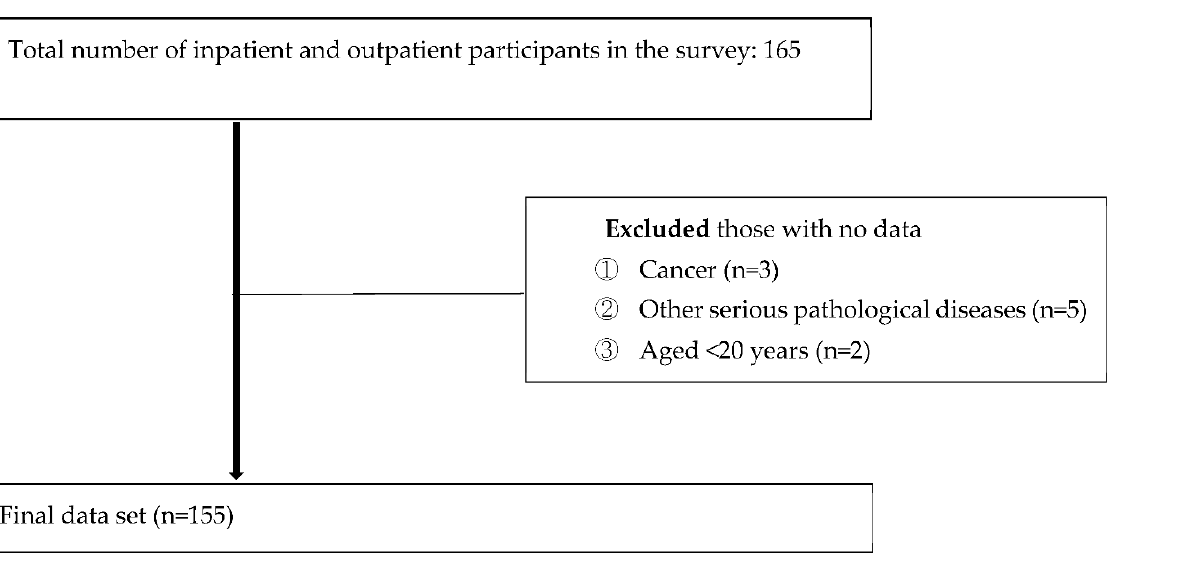
Figure 1. Flowchart of patients with chronic low back pain in this study.